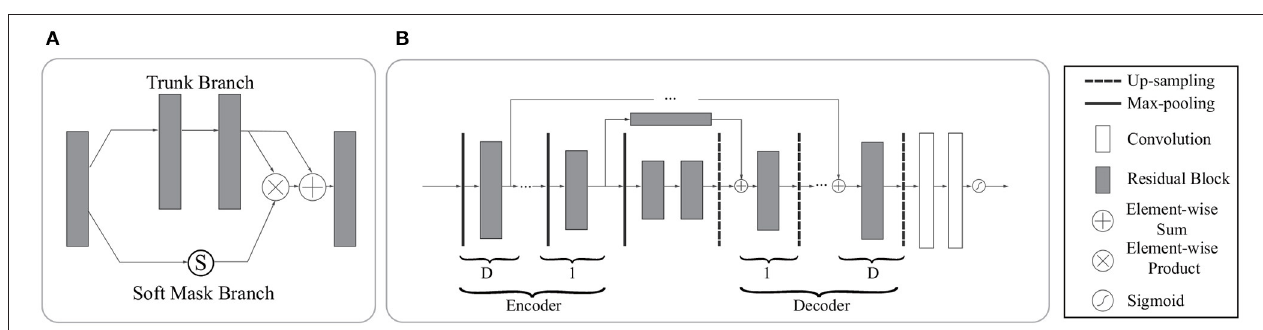
FIGURE 5 | The architecture of the attention residual module. (A) The attention residual module contains a trunk branch and a soft mask branch. The trunk branch learns original features while the soft mask branch focuses on reducing noises and enhancing good features. (B) The soft mask branch contains a stack of encoder-decoder blocks. D denotes the depth of skip connections. In our network, we set D to 0,1,2,3 according to the specific location of the attention residual block.